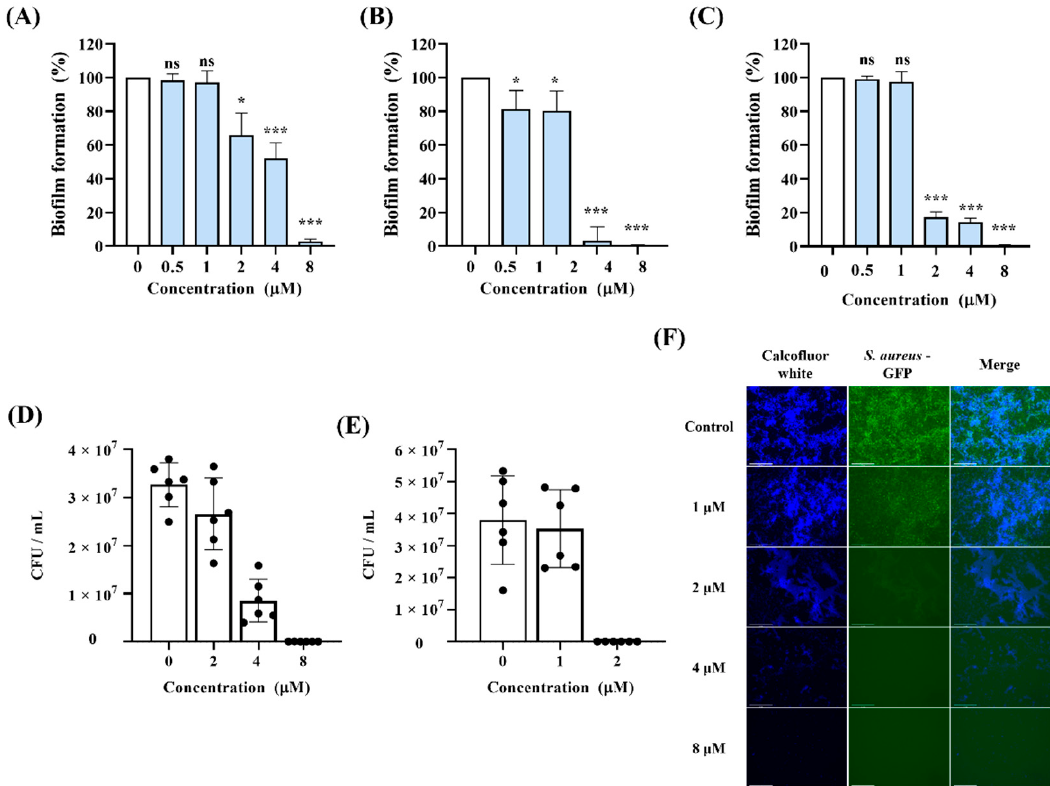
Figure 5. The inhibitory effect of Lycosin-II on biofilms formed by one or two microbial species. Biofilms formed by a single strain, ( A ) Candida albicans (CCARM 14020) or ( B ) Staphylococcus aureus (ATCC 25922), and ( C ) dual-species biofilms containing C. albicans and S. aureus were incubated with Lycosin-II. The biofilm mass was quantified by using crystal violet and measuring the optical density at 595 nm. The colony-forming unit (CFU) numbers of ( D ) C. albicans and ( E ) S. aureus in the dual-species biofilms were analyzed using a plating method on yeast extract peptone dextrose and Luria–Bertani medium supplemented with vancomycin and amphotericin B, respectively. Black dot indicated number of C. albicans and S. aureus . ( F ) The viability of the dual-species biofilm was analyzed using fluorescence microscopy. C. albicans was stained using calcofluor white (blue), and S. aureus expressing green fluorescent protein (GFP; green) was used to detect the bacterial cells. The graph is expressed as the mean ± standard deviation. Significance: *, p < 0.05; ***, p < 0.001; ns, not significant compared with control.